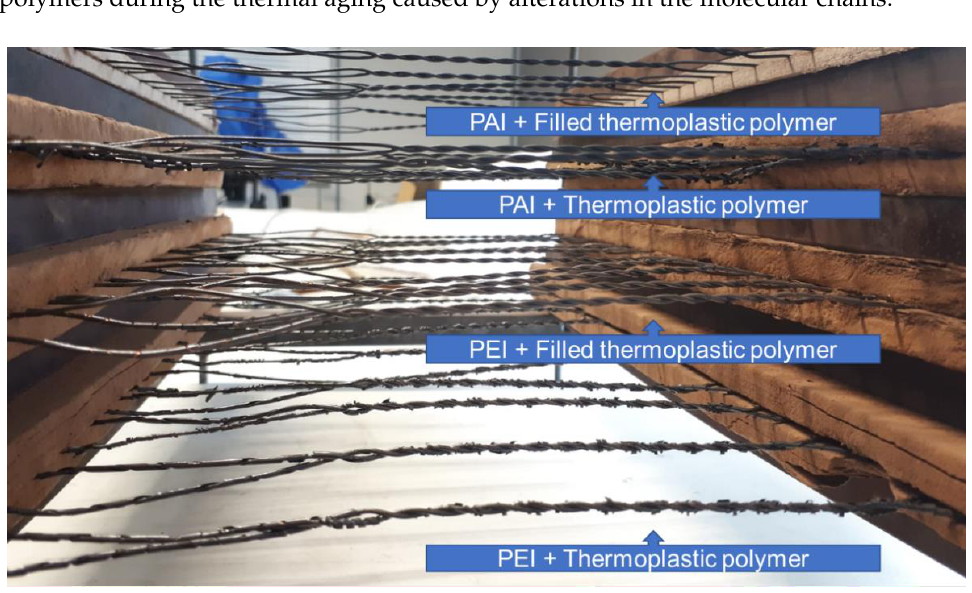
Figure 10. Improved aspect of filled thermoplastic polymer extruded layer after aging test at 250 °C.